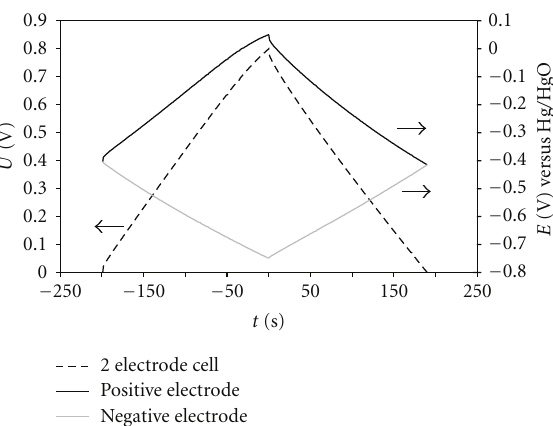
Figure 6: Galvanostatic charge/discharge at 200 mA/g (C = 95F/g—two-electrode cell) for a supercapacitor built from composite W3.